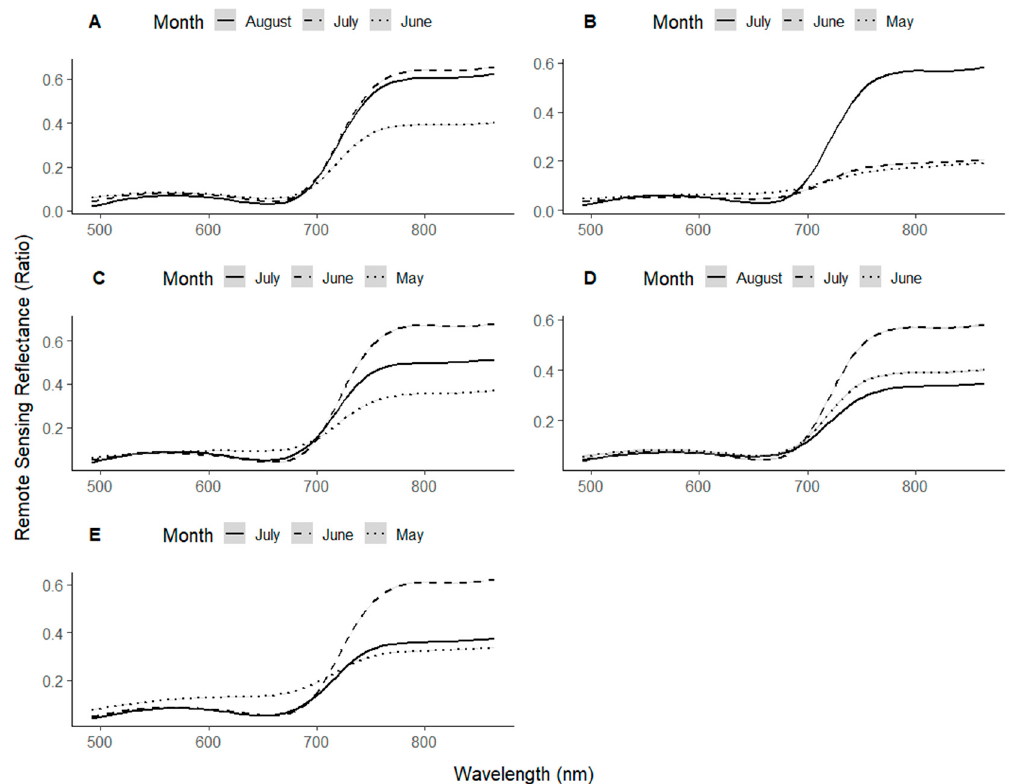
Figure 7. Smoothed spectral signatures of the potato canopy at the 3 different times of the season at Buttery Hill ( A ), HF7 ( B ), Deaton 6 ( C ), Horse Foxhole ( D ), and Crabtree Leasow ( E ).